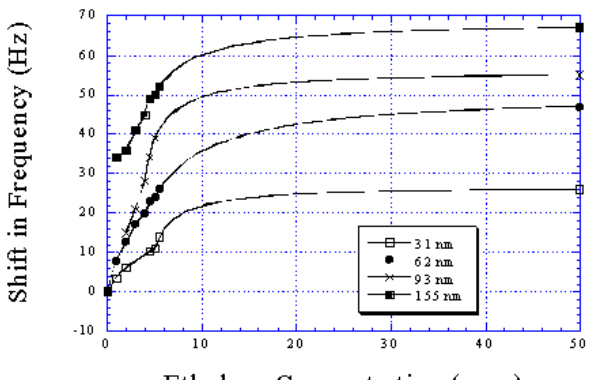
Figure 5. Shift in measured resonant frequency of ethylene sensors, of variable Pt-TiO coating thickness approximately, as a function of ethylene concentration. Measurements were taken at 19°C.